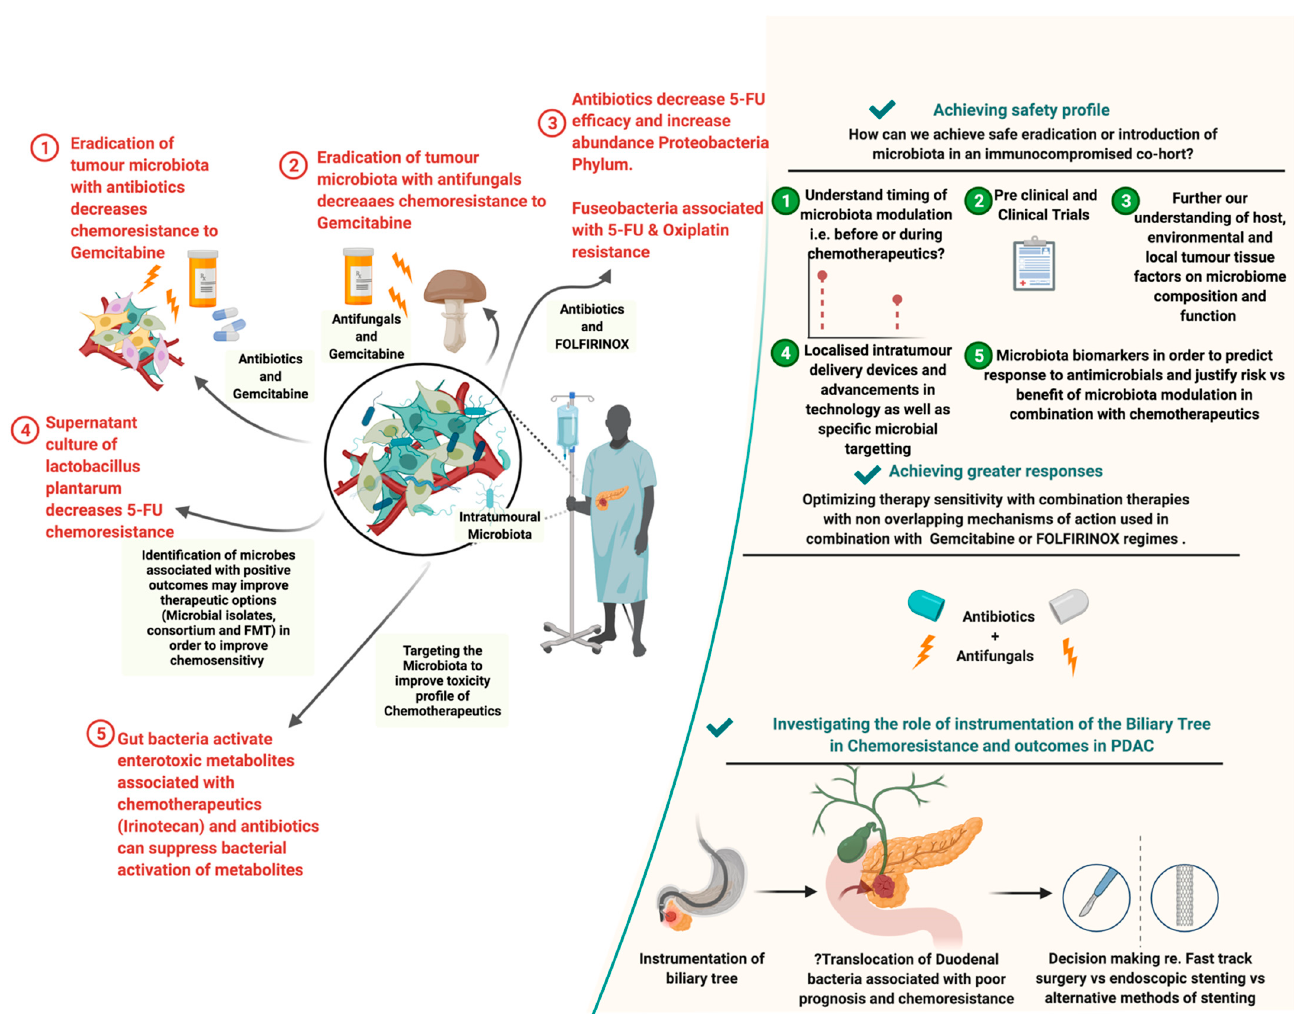
Figure 3. Highlighting ( left ) current findings and the potential roles microbiome modulation may play in the future of PDAC chemotherapeutics. In this illustration ( right ), we also suggest several focuses of future research which may prove critical in establishing the role for microbiome modulation and chemotherapeutics.